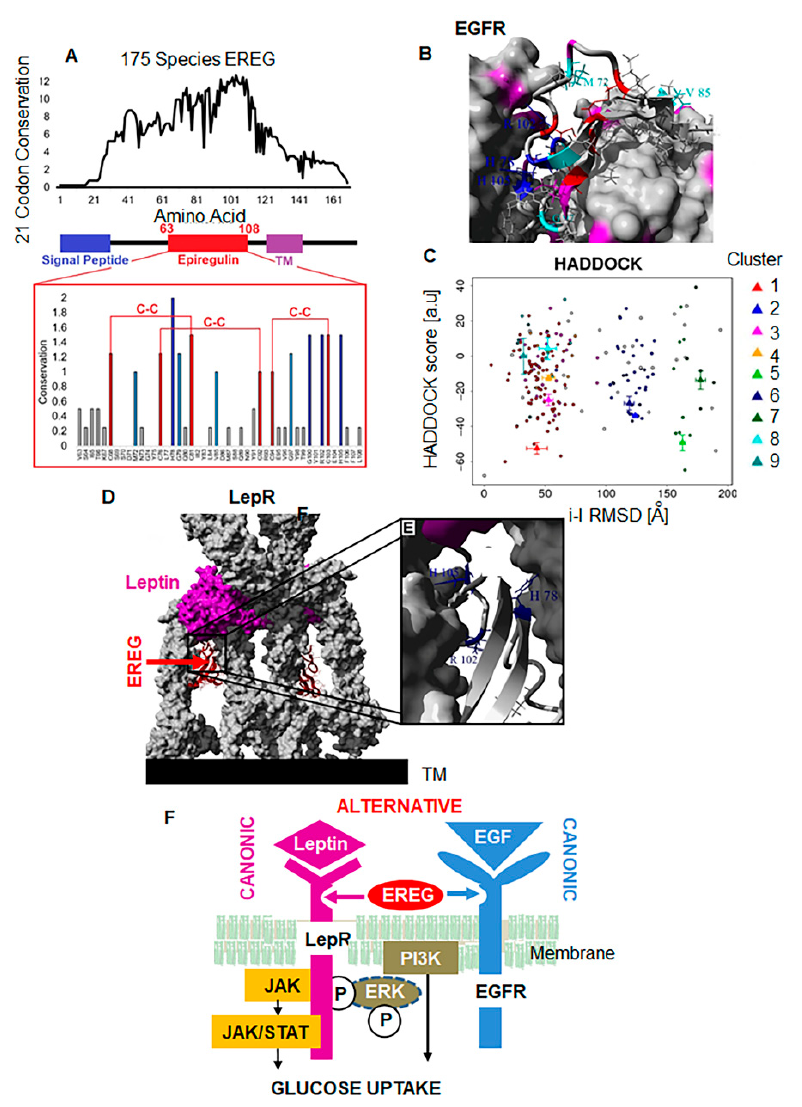
Figure 6. Evolutionary analysis of EREG binding to LepR. ( A – E ) EREG docking to LepR. Evolutionary analysis of 175 open The dependence of EREG-mediated glucose uptake on the ERK phosphorylation cascade was examined using (1) a specific inhibitor of ERK1/2 SCH772984 [56], (2) an inhibitor of ERK dimerization DEL-22379 [57], and (3) a selective inhibitor of MEK1 and MEK2 U0126 [58]. All inhibitors increased basal glucose uptake, which was further increased by leptin (Figure 4F). The inhibition of ERK1/2 and MEK1/2 as well as ERK dimerization prevented stimulatory effect of EREG on FD-glucose uptake but did not decrease it beyond the levels seen in the control cells. Although transient ERK phosphorylation occurred in response to EREG stimulation, this pathway was dispensable for glucose uptake and dependent on PI3K and may be other pathways (Figure 4B and Figure S7B). ( F ) Hypothetic mechanism suggesting EREG as an alternative ligand for both EGFR and LepR. The canonic leptin/LepR response can induce JAK/STAT3 signaling and required the long form of LepR. The alternative binding of EREG to LepR can induce ERK and PI3K activation increasing GLUT4 translocation and glucose uptake, but not the other canonic effects of leptin, including the regulation of appetite and energy